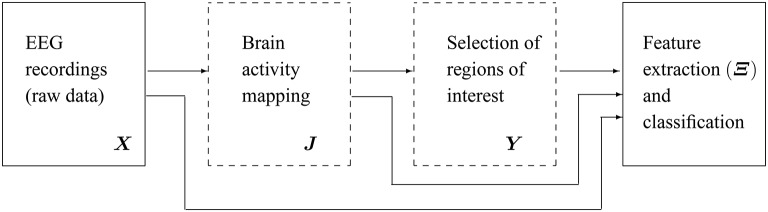
Scheme of the proposed methodology for discrimination of emotions using extracted features from EEG source reconstruction. The blocks marked in dashed lines are the subject of present study.